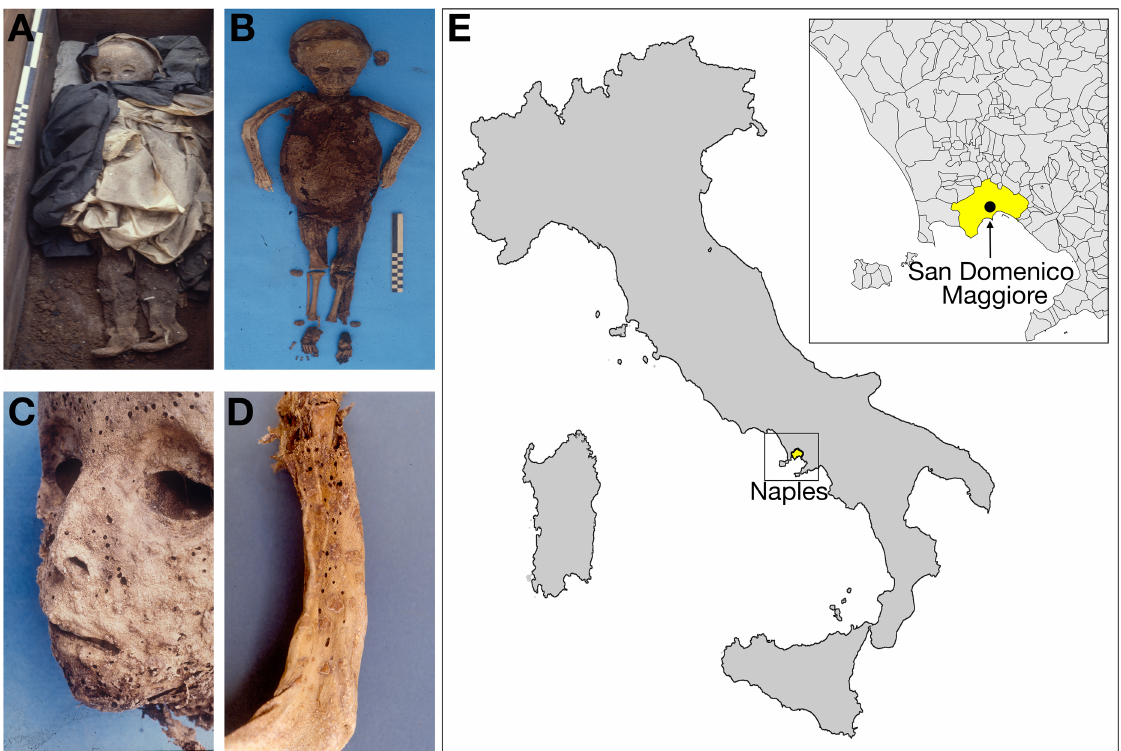
Fig 1. Location and subject. Images of NASD24 showing(A) the mummy wearingfunerary dress in the coffin, (B) the child’s mummified body prior to the autopsy, (C) the vesicopustular rash as evident on the facial features, and (D) this rash as evidenton the arm. (E) Map displayinglocationof the Basilicaof Saint DomenicoMaggiore in Naples, Italy. The map of Italy was constructed in Matlab v2016busing the landareas.shp to define the outline of the landmassof Italy. The shapefileobtainedfrom the Italian NationalStatistics Institute (ISTAT) (http://www3.istat.it/dati/catalogo/20061102_00/) was used to define the Italian administrative borders as displayedwithin the inset focused on Naplesand showingthe exact location of San DomenicoMaggiore (latitude = 40.849027,longitude= 14.254418).